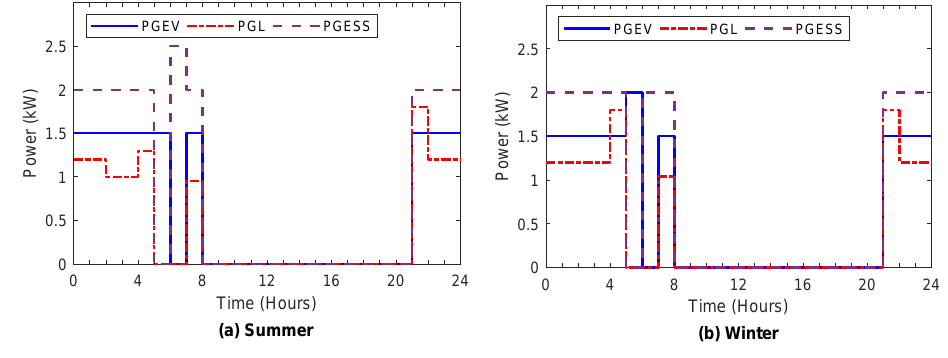
Figure 9. Procured power from grid. Figure 10a,b illustrate sold power to the grid in summer and winter, respectively, including the power sold to the grid from PV and ESS. It is noted that PV power is sold to the grid as soon as the PV generation is redundant, while the energy stored in the ESS is not sold to the grid unless the electricity prices are high, which increases the income of selling electricity.